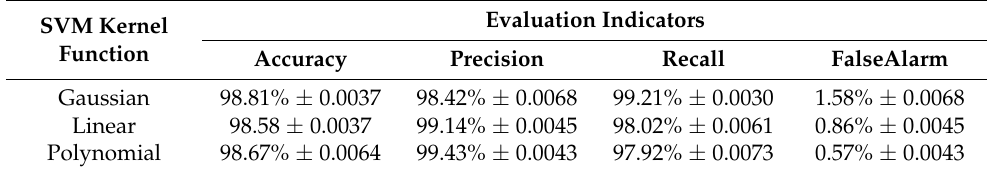
Table 4. Summary of evaluation indicators using different SVM kernel